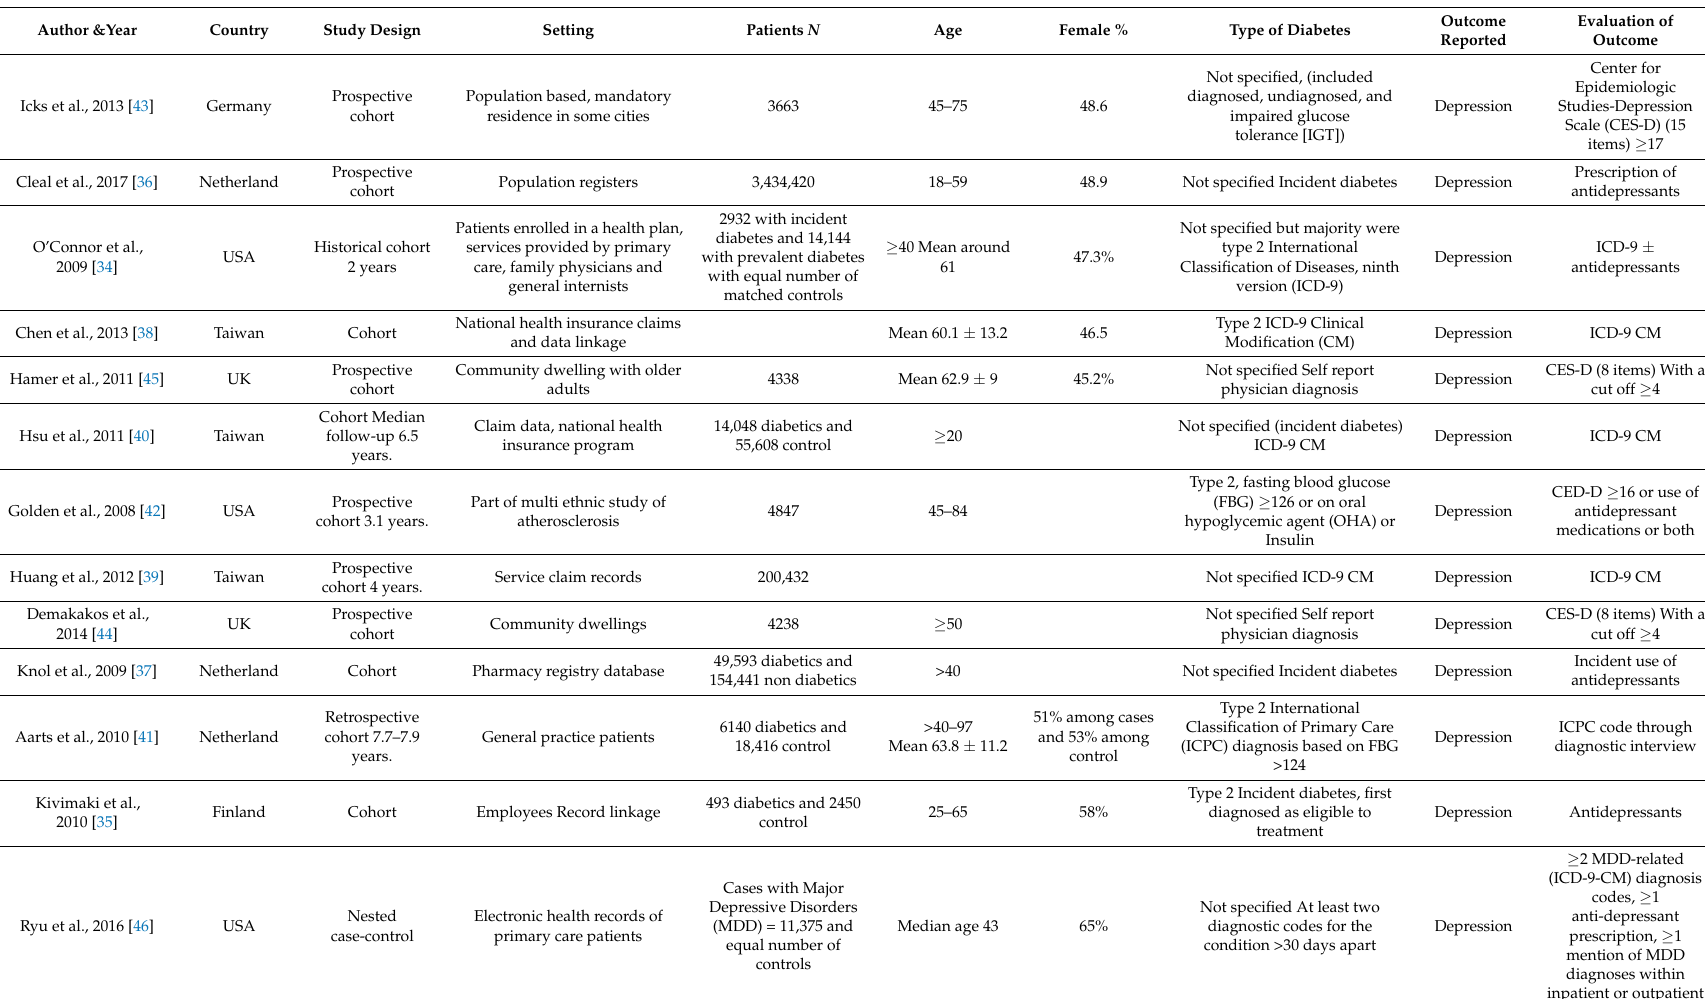
Table 1. Characteristics of selected depression